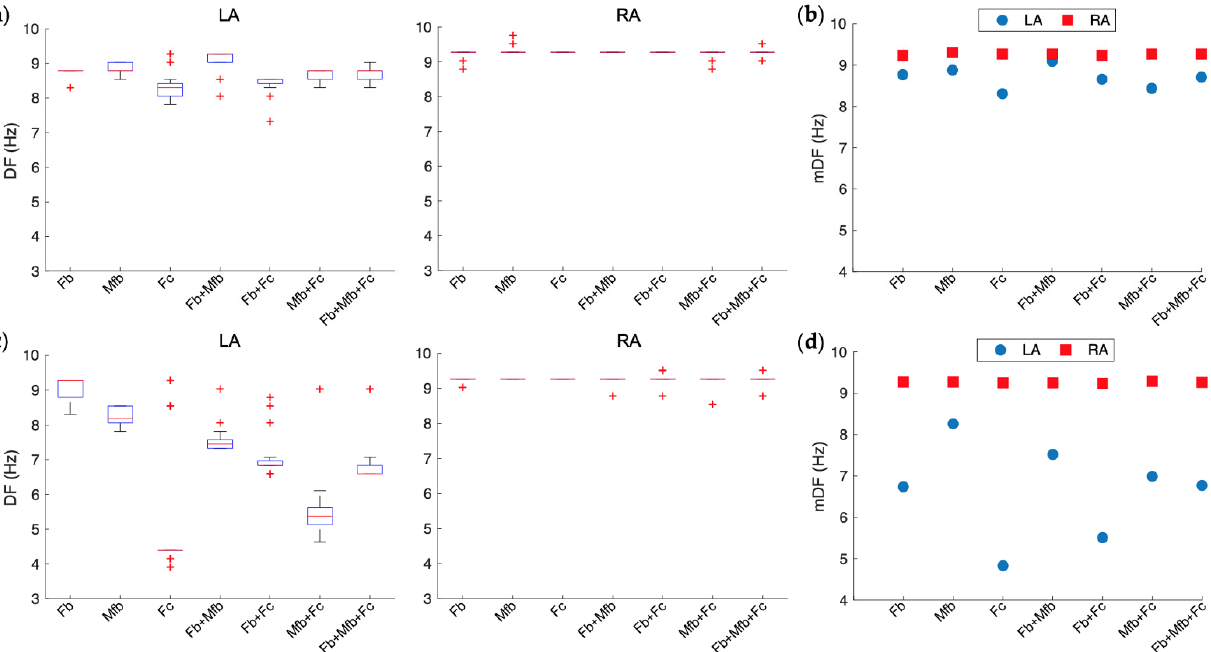
Table 3. Values of mDF and left-to-right DF gradient, at low and high density with different fibrosis configuration. Fibrosis Configuration Fibrosis Density LA mDF (Hz) RA mDF (Hz) Without fibrosis -